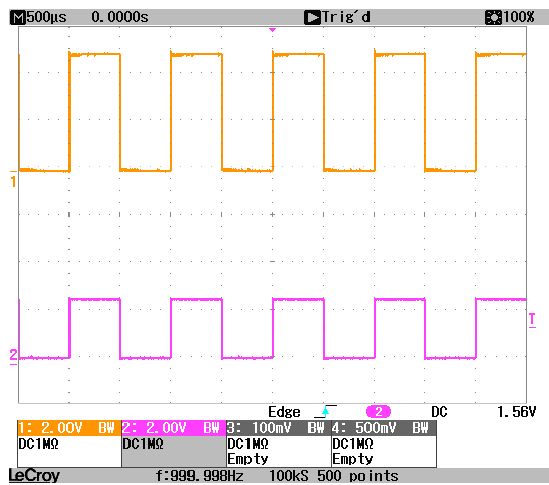
Figure 4. Screenshot taken from a LeCroy Wavejet 324 osciloscope. The orange signal is produced by a pulse wave generator and the purple one is acquired on the receiver output pin.